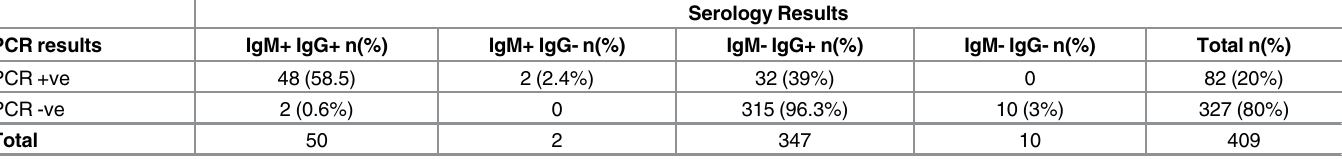
Table 3. Results of IgM, IgG and PCR testing for diagnosis of CMV infection in pregnant women.